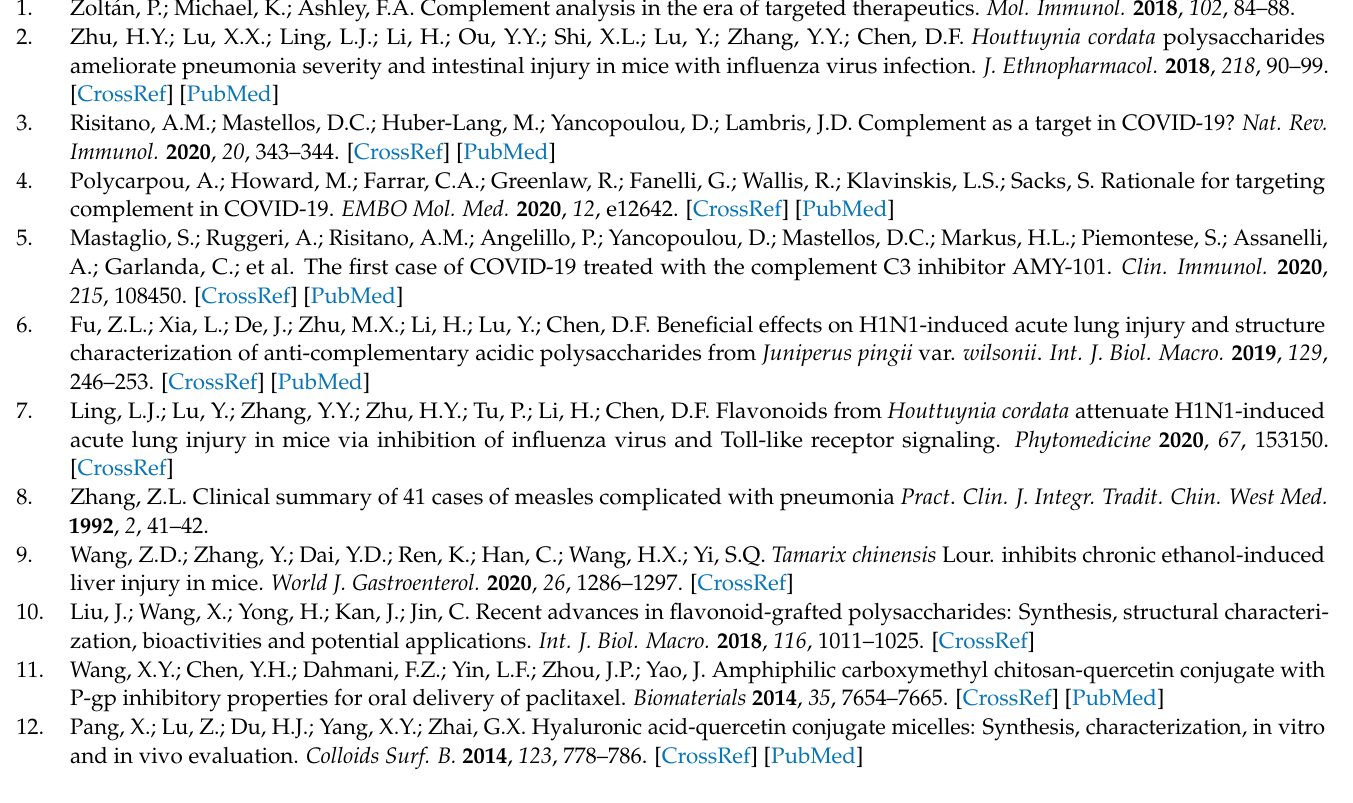
Table S1: The detailed setting parameters in NMR experiments; Figure S1: The HPGPC-ELSD results of MBAP-1 and MBAP-2; Figure S2: The GC-MS spectrogram of monosaccharide of MBAP-2; Figure S3: FT-IR spectroscopy analysis of MBAP-1 and MBAP-2; Figure S4: The mass spectra of PMAAs of MBAP-1; Figure S5: The mass spectra of PMAAs of MBAP-2; Figure S6: The 1 H- and 13 C-NMR spectra of MBAP-1; Figure S7: The 1 H- and 13 C-NMR spectra of MBAP-2; Figure S8: The 1 H-NMR and 13 C-NMR spectra of quercetin in d 6 -DMSO and d 6 -DMSO: D 2 O (1:1).; Figure S9: The AFM results of MBAP-1 and MBAP-2. References [45,46] are cited in the Supplementary